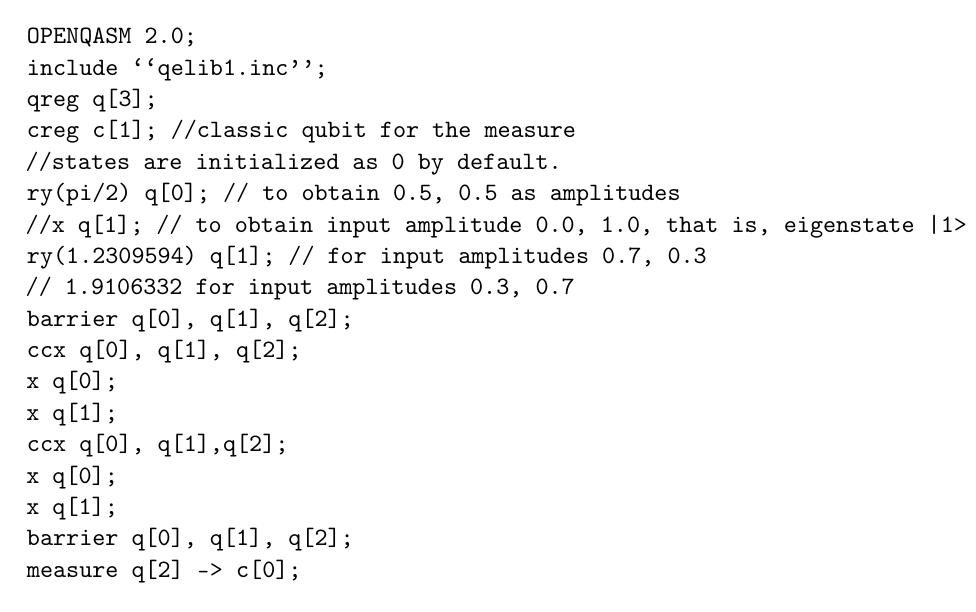
Figure 1. The considered quantum circuit for | q 0 (cid:105) = 1 √ ing the initializations of q 0 and q 1 through suitable R y gates, we can span the different